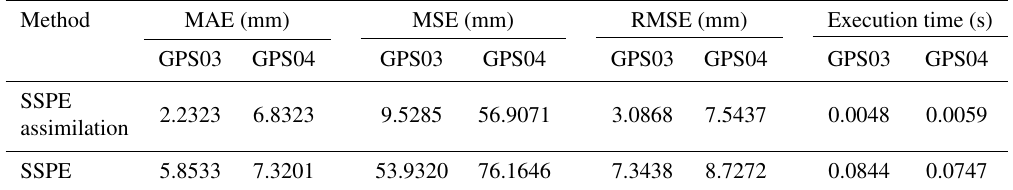
Table 3. Comparison of mean absolute error (MAE), mean squared error (MSE) and root mean square error (RMSE) performance and needed time using different methods in two